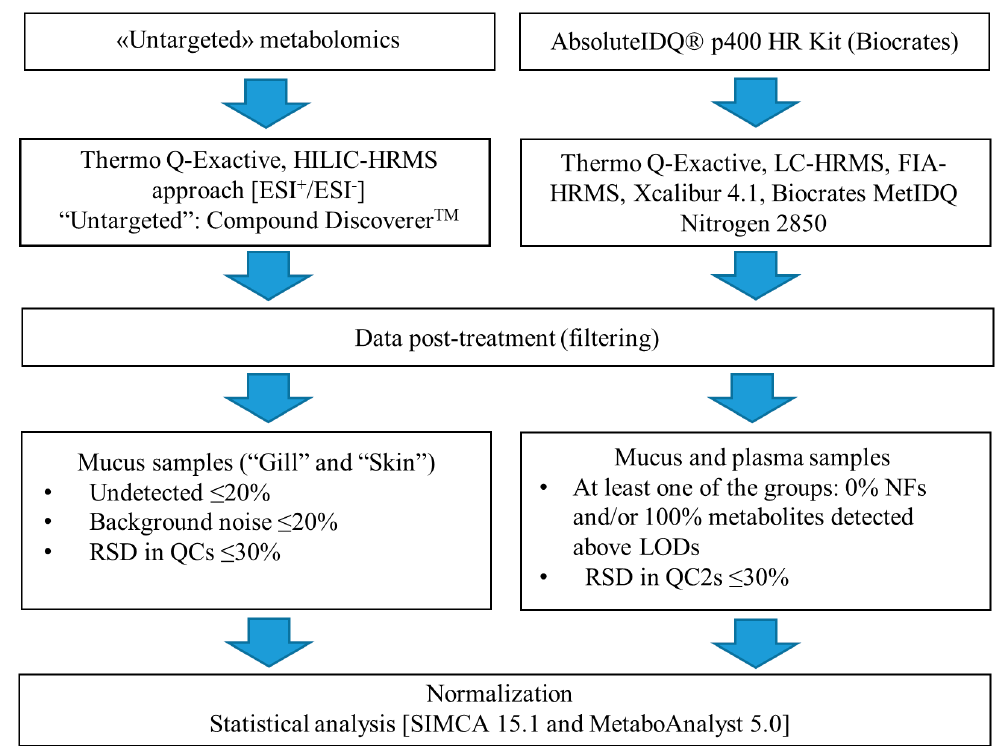
Figure 6. Flow chart overview of data collection and post-processing.